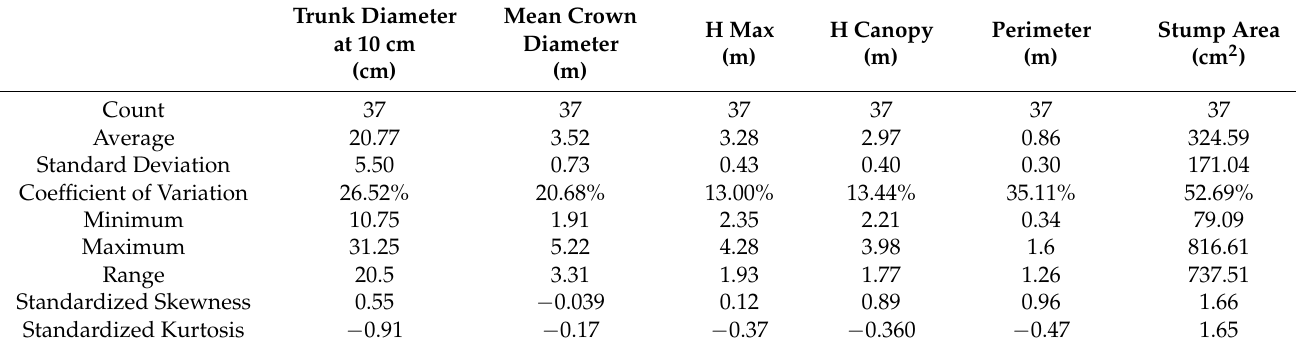
Table 1. Dendrometric variables studied.